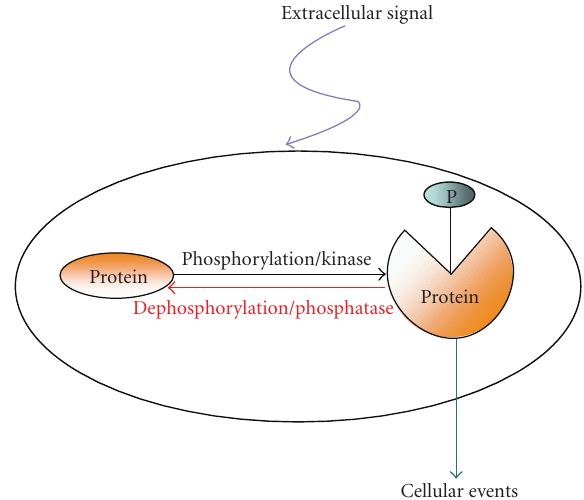
Figure 1: General principles of signal regulation by kinases and Phosphatases: the phosphorylation and dephosphorylation of the protein, the former being catalyzed by a kinase, and the latter by a phosphatase. Phosphorylation usually causes a conformational change in the